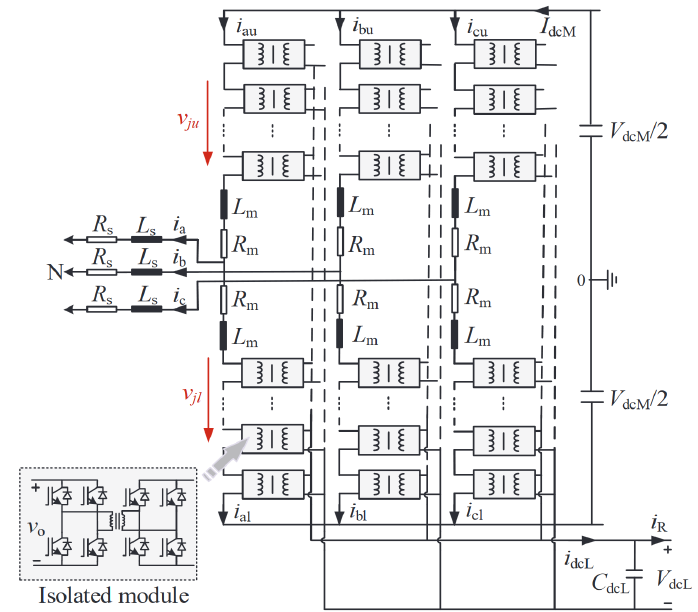
Figure 13. Isolated MMC-based SST used in [48]. In [49], a control strategy based on FCS-MPC is proposed to control the rectifier stage of the modular SST topology presented in Figure 14.